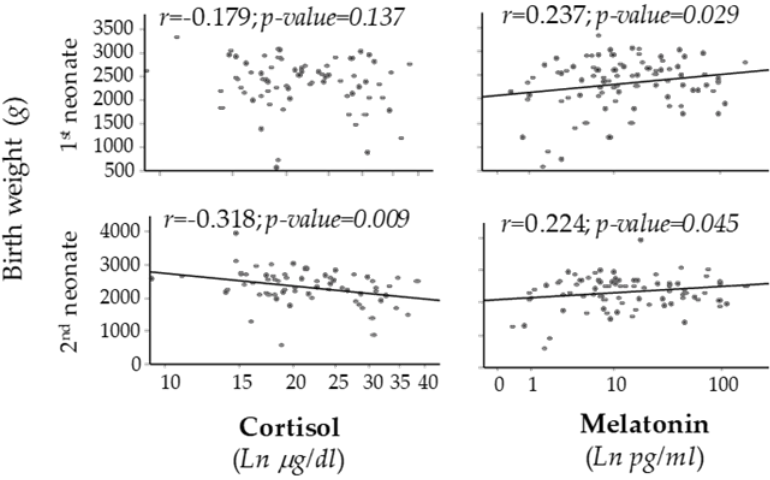
Figure 4. Scatter plots of birth weight vs. cortisol or melatonin levels. Line shows p < 0.05. Rho – Spearman